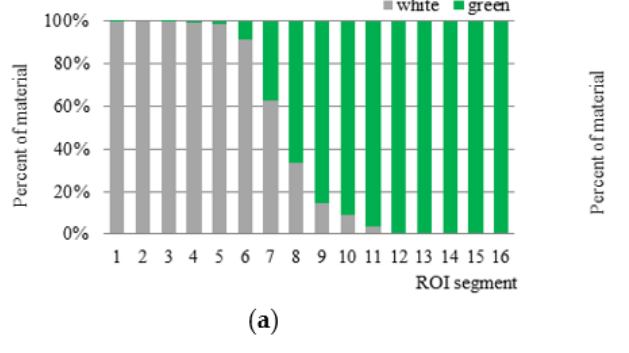
Figure 10. Results after 1 min. of tribocharging and separation: ( a ) percentage of PET and PE-HD in each ROI segments; ( b ) percentage of PET and PE-HD in relation to the surface of the ROI segments. The separation efficiency tests carried out using the developed vision system showed that the separation efficiency rapidly improves when the tribocharging time for the particle mixture of both materials in the range of up to about 5 min was increased. Further extending the tribocharging time only slightly improved the separation effi- ciency. Therefore, further studies of that separation efficiency and quality were per- formed for a tribocharging time of 5 min. The influence of the position of the deflecting electrode (Figure 11) and the drum rotational speed on RR and PUR of the separated PET and PE-HD particles was analysed.